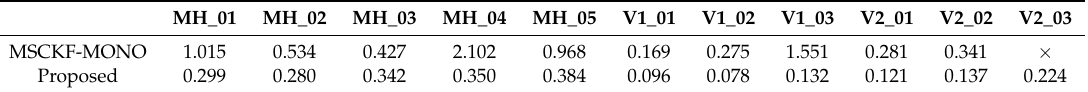
Table 3. Comparison results for proposed algorithm and MSCKF-MONO using the EuRoC